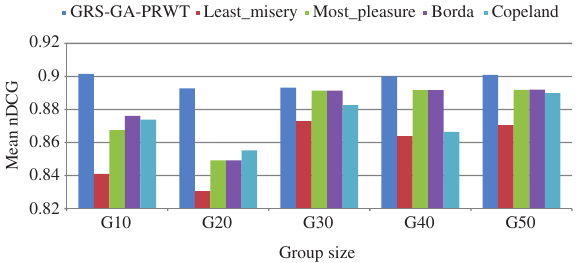
Group size Figure 14: The Effectiveness of Proposed GRS-GA-PRWT Compared to Baseline Techniques Based on Mean nDCG for Different Group